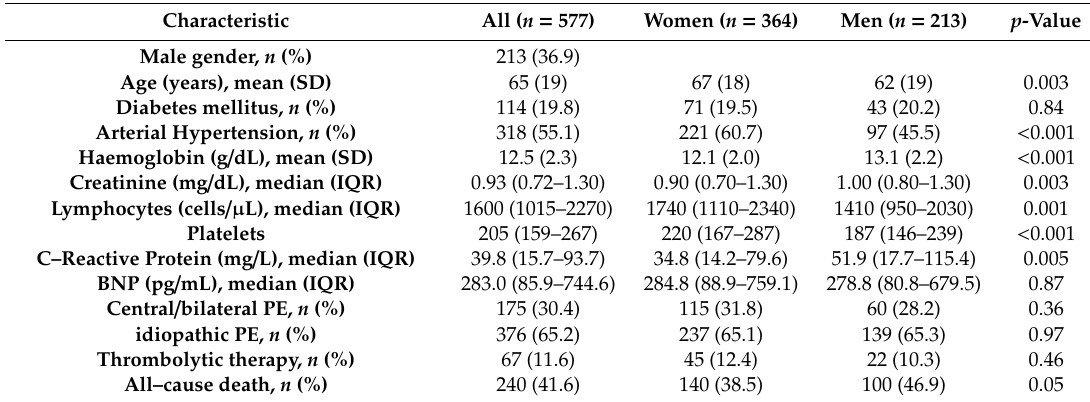
Table 1. Patients’ characteristics and comparison between